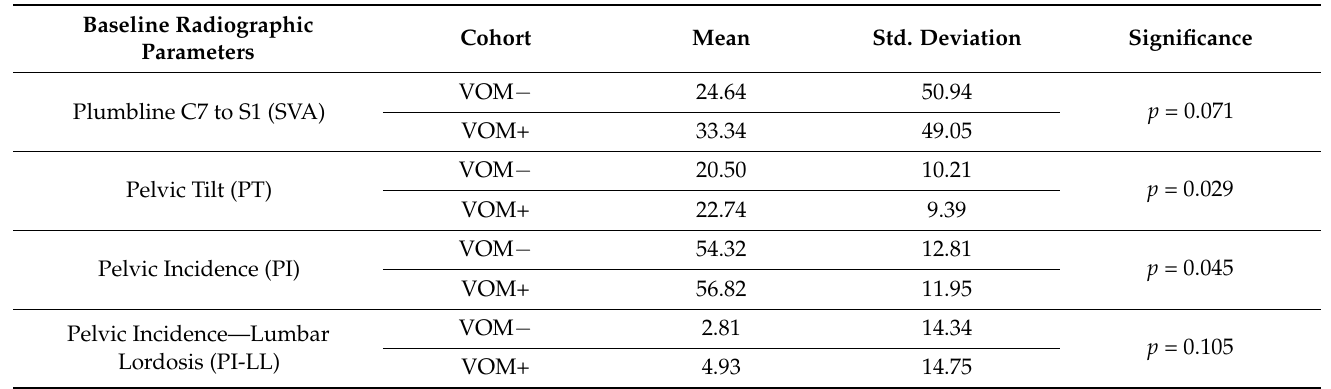
Table 4. Baseline radiographic comparison of VOM+ and VOM − patients.